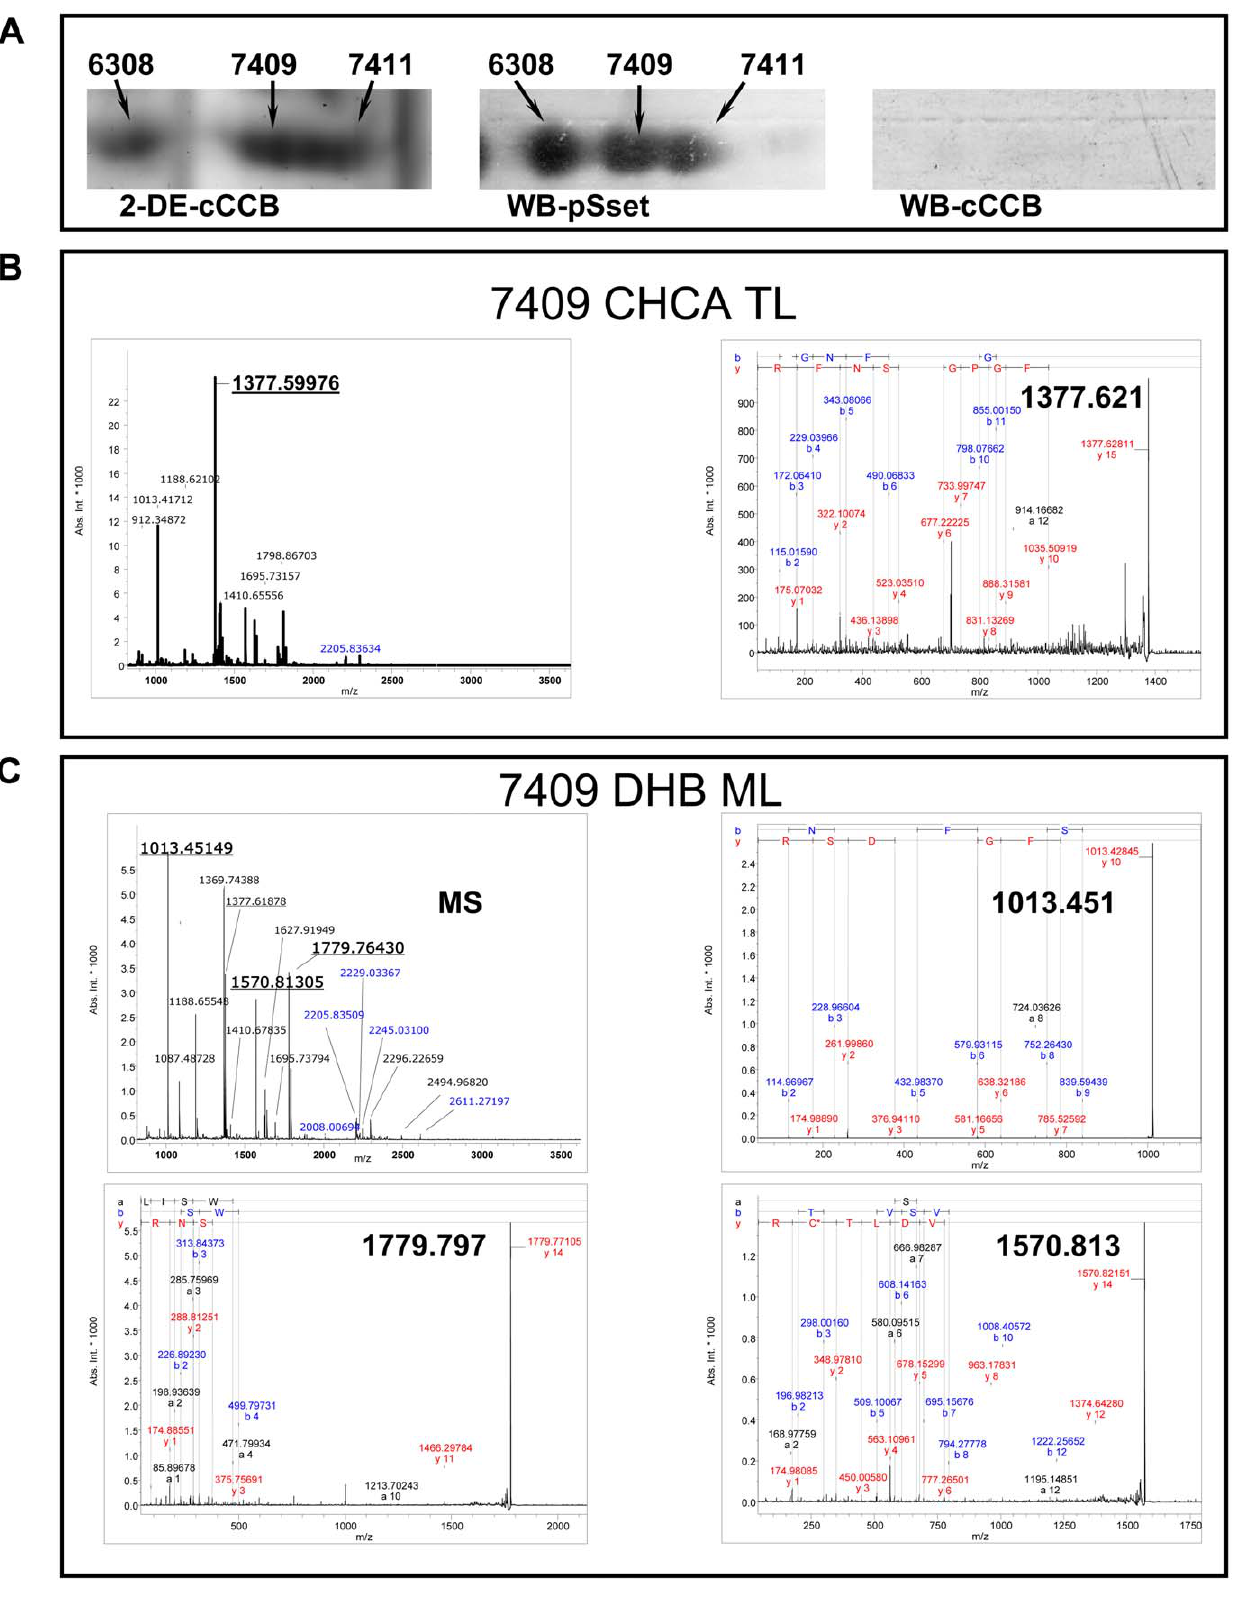
Figure 3. Identification of phosphoproteins with the pSset of MAbs and by MALDI-TOF mass spectrometry using two different matrix layer sample preparation methods. Two different MALDI sample preparation methods in combination enabled reliable identification of proteins. Panel A: In 2-DE-cCBB stained gels spot 7409 and 7411 are not well separated but WB with the pSset MAbs resolved three distinct spots.